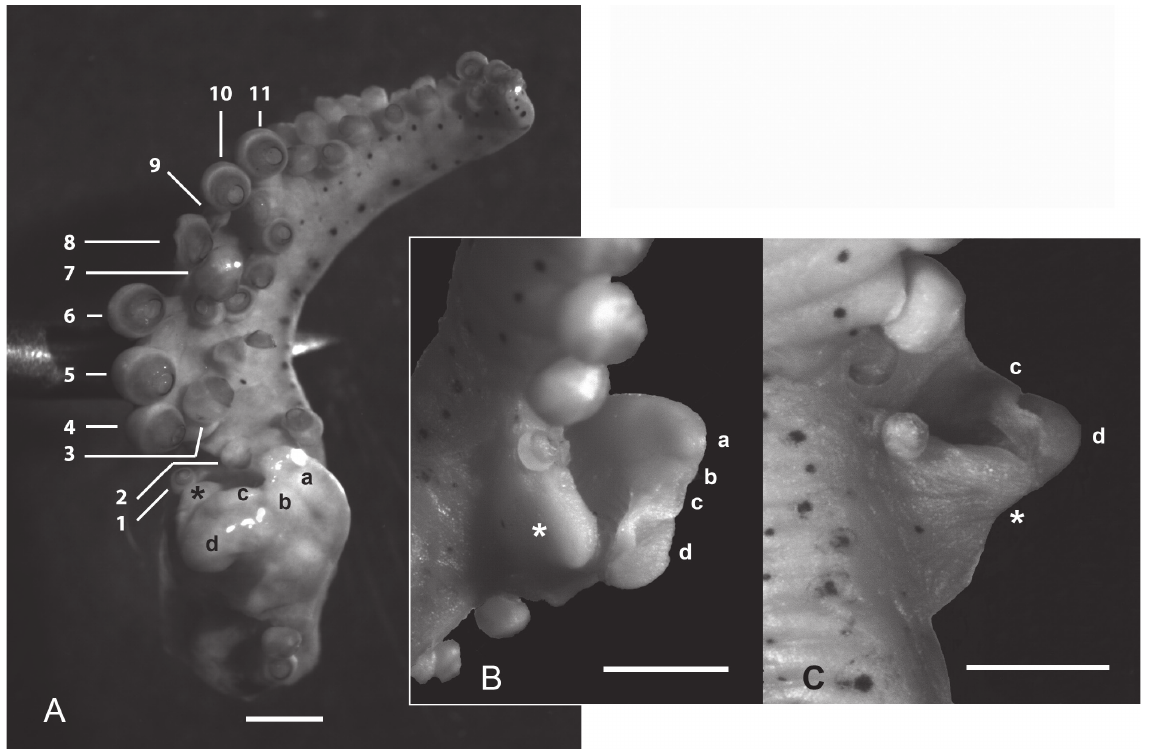
Fig. 6. Hectocotylus (left arm I) of Sepiola boletzkyi sp. nov., holotype, ♂,